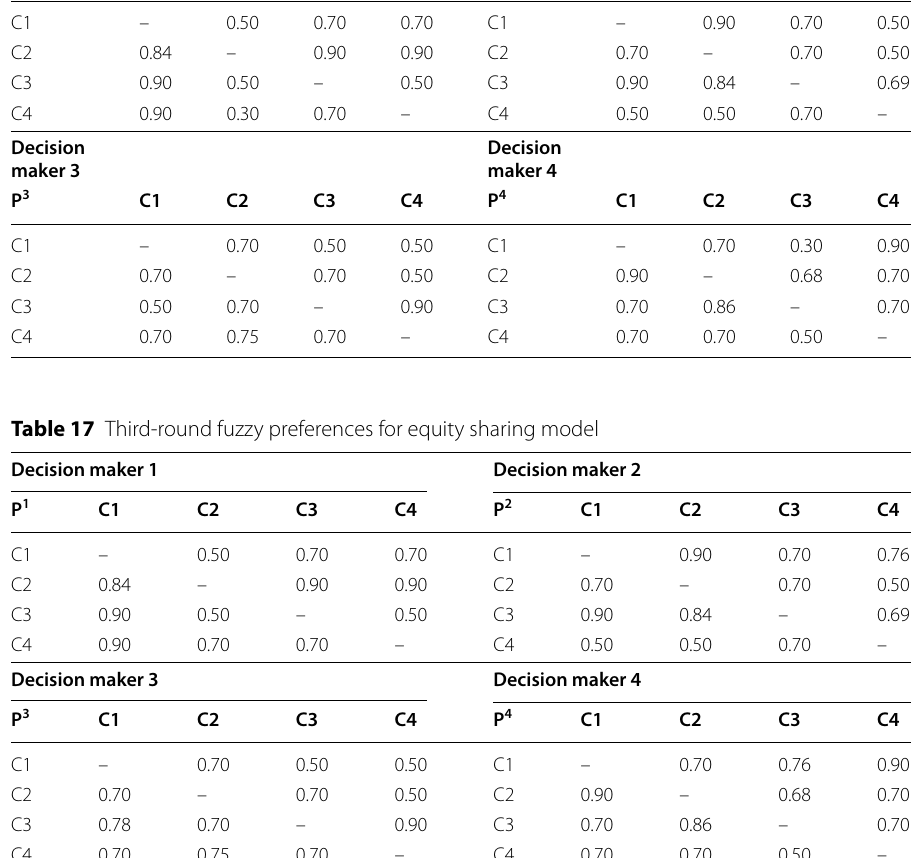
Table 16 Second-round fuzzy preferences for equity sharing model Decision maker 1